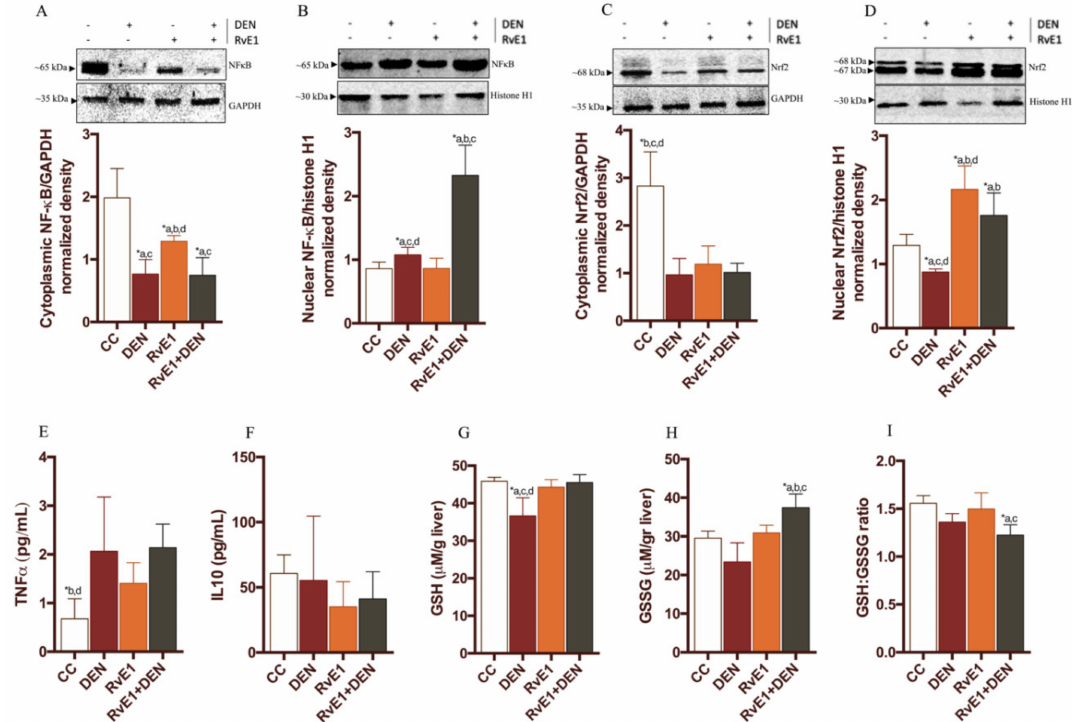
Figure 5. E ff ect of RvE1 on tissue levels of NF- κ B and Nrf2, and molecules targets. Western blot analysis of ( A ) cytoplasmic and ( B ) nuclear NF- κ B; and ( C ) cytoplasmic and ( D ) nuclear Nrf2. The cytoplasmic levels were normalized to GAPDH as housekeeping and nuclear levels were normalized to histone H1 as housekeeping. ( E , F ) serum levels of TNF- α and IL-10. ( G – I ) tissue levels of GSH, GSSG and GSH:GSSG ratio. n = 6–9 rats per experimental group. Asterisk indicates p < 0.05, and the letters identify the experiments that are compared and present this statistical di ff